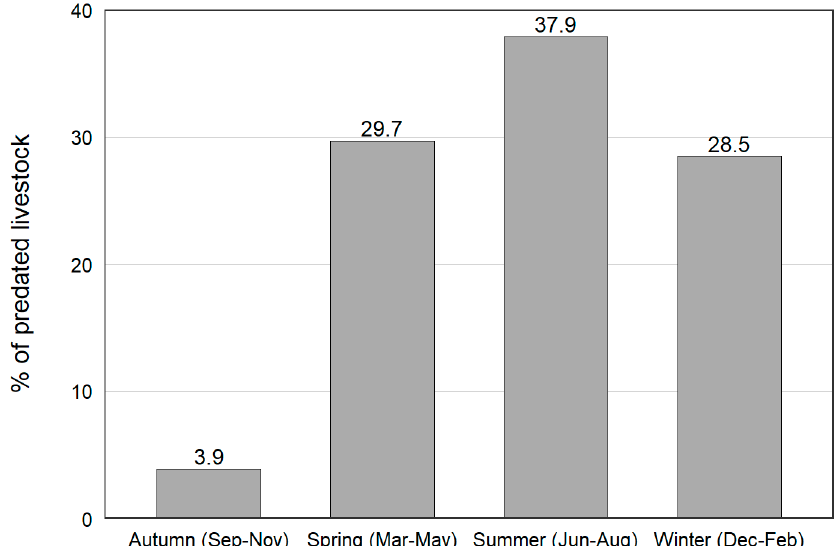
Figure 2. Depredation of livestock by snow leopards across seasons among surveyed households ( n ( n = 65) during years 2017 / 18 and 2018 / 19. = 65) during years 2017/18 and 2018/19.